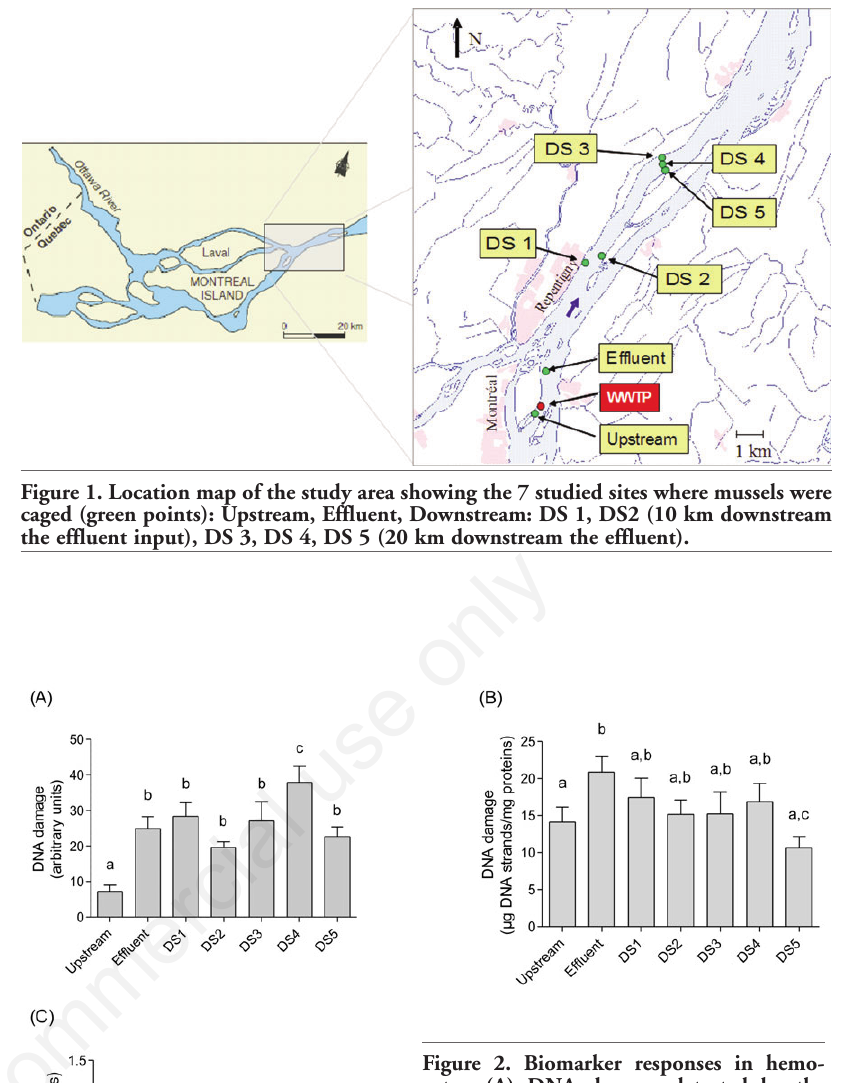
Figure 2. Biomarker responses in hemo- cytes. (A) DNA damage detected by the Comet assay, (B) DNA damage measured as DNA strands by alkaline precipitation, (C) Lipid peroxidation of hemocytes mem- branes. Results are expressed as mean±SD, n=8. Differences between sites were tested using one-way ANOVA and Mann Whitney U test. Different letter indicates significant difference (P<0.05).